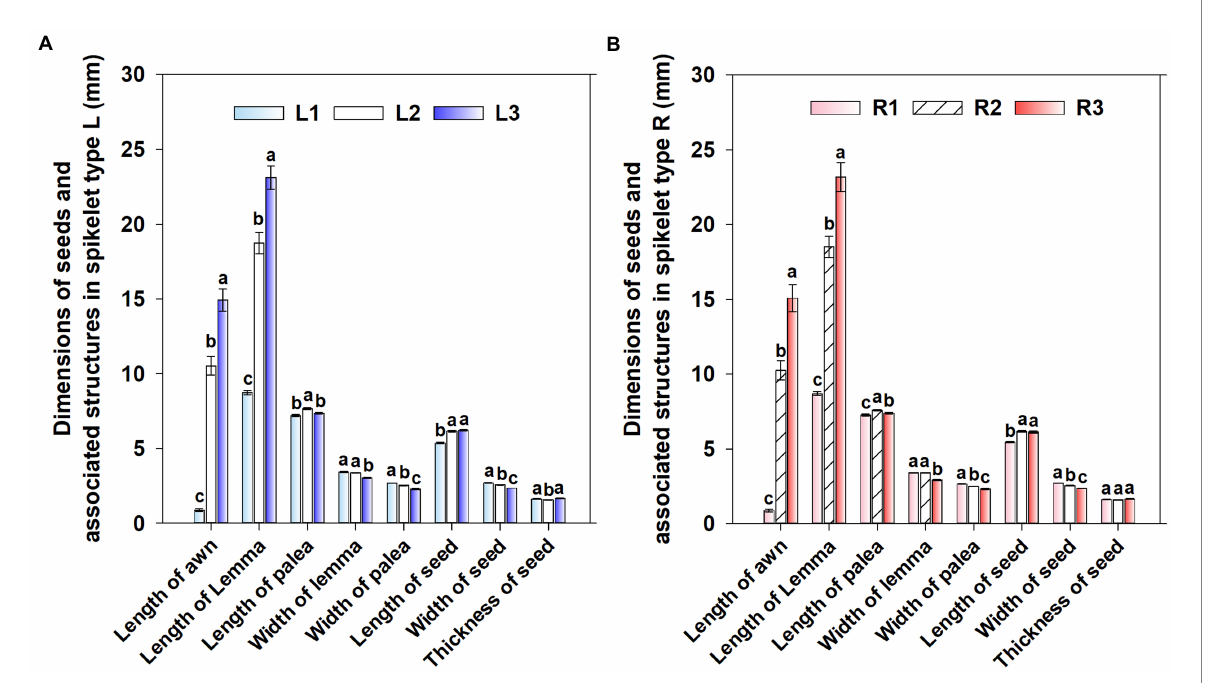
FIGURE 2 Dimensions (mm, mean ± standard deviation) of seeds and associated structures in the spikelet type L (A) and R (B) of Aegilops tauschii ( n = 50). L, spikelet type Left; R, spikelet type Right; numbers 1, 2, and 3 following abbreviations indicate different seed groups. Different letters between seed groups for each dimension and each type of spikelet indicate significant differences (Tukey’s HSD, p =